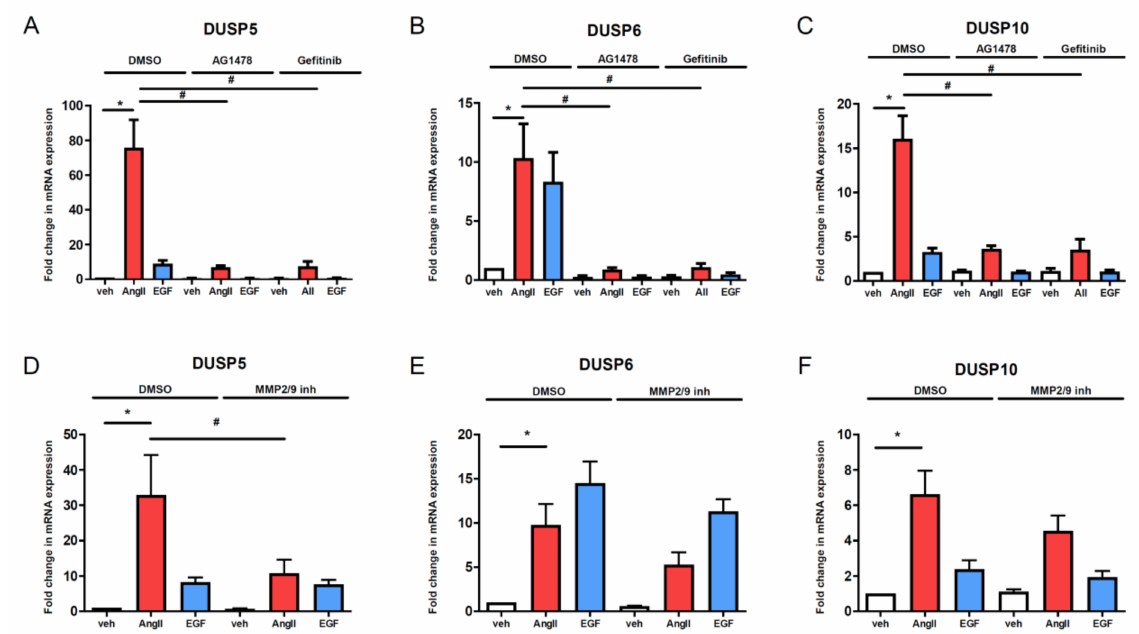
Figure 5. Effect of EGFR transactivation on the gene expressional changes of DUSP isoforms in VSMCs. Serum starved cells were incubated with either 1 µ M AG1478 ( A – C ) or 2.5 µ M gefitinib ( A – C ), or 1 µ M MMP-2/MMP-9 Inhibitor II ( D – F ) beside the control treated with DMSO for 30 min, then the cells were exposed to either 100 nM AngII (red columns) or 50 ng/mL EGF (blue columns) or vehicle (white columns) for 2 h. mRNA levels of DUSP5 ( A , D ), DUSP6 ( B , E ) and DUSP10 ( C , F ) were measured by qPCR. Standardization was made against the GAPDH housekeeping gene. The mRNA levels were normalized to values of DMSO vehicle samples and expressed as fold change. The values are from three-six independent experiments. Mean values ± S.E. are shown. Significance was determined with multiple linear regression. p < 0.05 was considered as statistically significant. *: statistically significant from vehicle stimulation. #: statistically significant from DMSO-pretreated agonist-induced response. The values are from three to six independent experiments ( n =